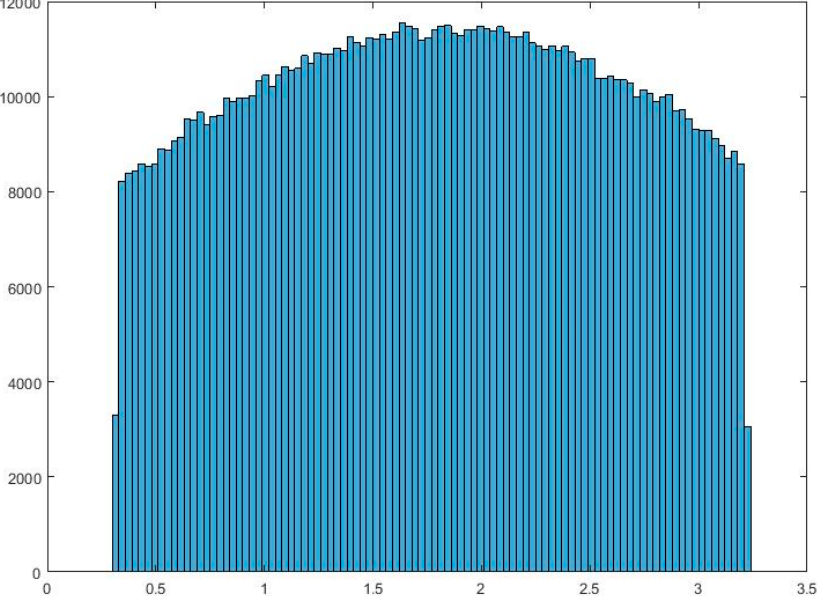
Figure 14. Histogram of generated random inputs created with truncated Gaussian function.